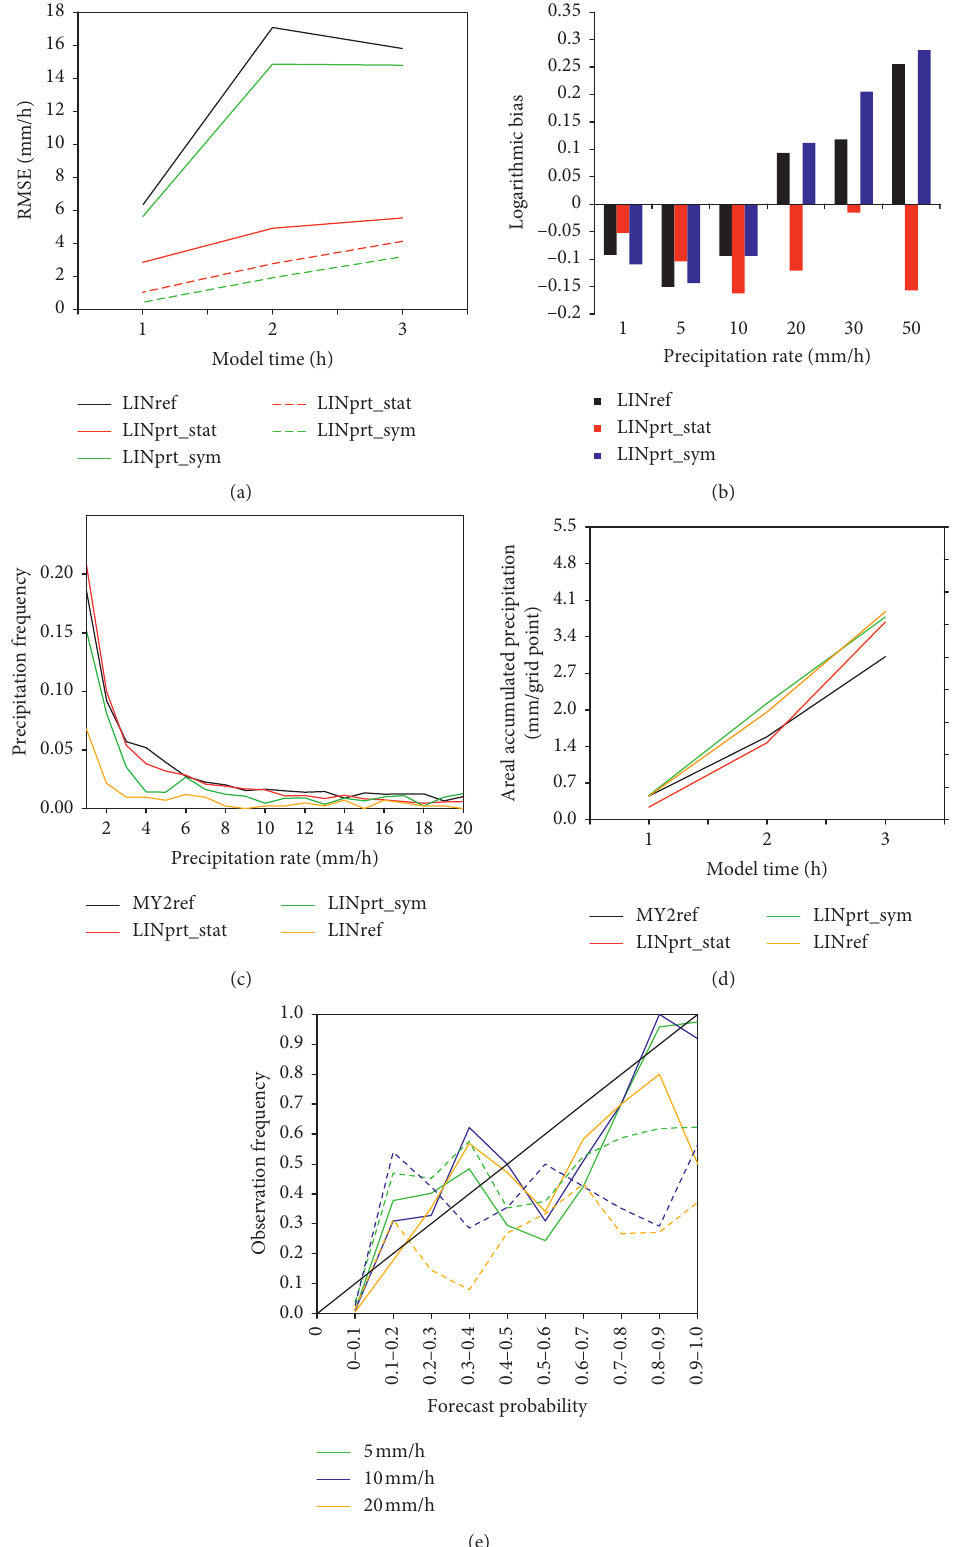
Figure 5: (a) RMSEs of the ensemble mean (solid) and ensemble spread (dashed) for hourly precipitation, (b) the logarithmic bias of hourly precipitation averaged over all members and all times, (c) the time averaged hourly precipitation frequency throughout the entire ensemble, (d) the areal accumulated hourly precipitation where the values for LINprt_stat and LINprt_sym are averaged over all members, and (e) the reliability diagram for LINprt_stat (solid) and LINprt_sym (dashed). The MY2 scheme serves as the